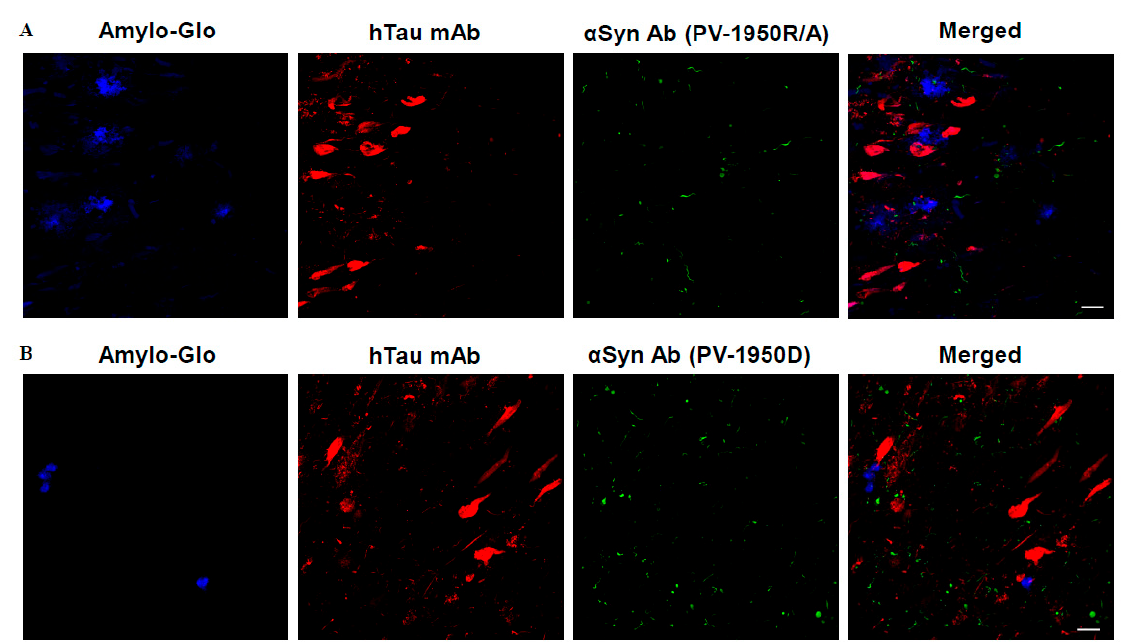
Figure 3. IgG antibodies induced by PV-1950R/A ( A ) and PV-1950D ( B ) vaccines in D line h α -Syn Tg mice recognized LBs in the brains from DLB/AD cases. Co-staining of the brain sections with anti- α -Syn antibodies induced either by PV-1950R/A or PV-1950D (green), Amylo-Glo (blue), and rabbit anti-total hTau antibodies (red), showing the presence of LB, amyloid plaques, and tau tangles in amygdala sections of DLB/AD brain, respectively. Magnification 40 × , scale bar 20 µ m.